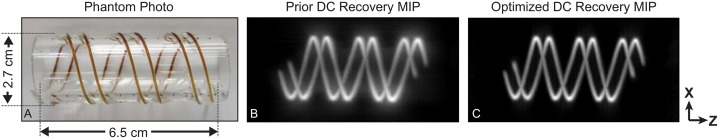
Experimental MPI data from a double helix phantom.The 3d dataset was reconstructed using the previous dc recovery method and the proposed method. Both datasets are shown as maximum intensity projection images with no deconvolution. Images reconstructed with the proposed method contain less background haze and fewer artifacts. The imaging phantom was constructed by wrapping two 0.6mm id tubes injected with Micromod Nanomag mip
mnps around an acrylic cylinder of od 2.7 cm. The total imaging time was 10 min with a fov of 4.5 cm by 3.5 cm by 7.5 cm (x,y,z).